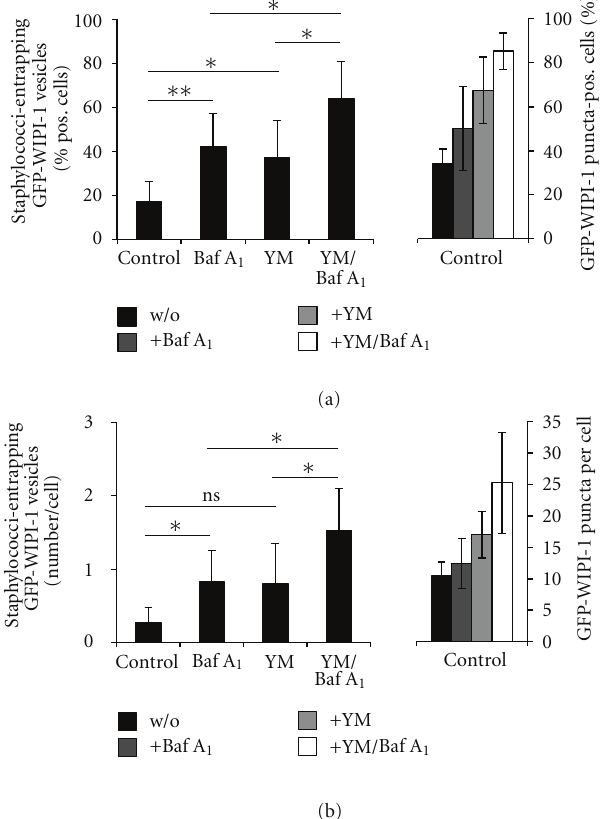
Figure 8: Bafilomycin A 1 and YM201636 treatments increased the number of GFP-WIPI-1 positive autophagosome-like vesicles entrapping Staphylococci. GFP-WIPI-1 U2OS cells were infected with S. aureus USA300 in DMEM/FCS in the absence (control) or presence of 200nM bafilomycin A 1 (Baf A 1 ), 800 nM YM201636 (YM), or with both (Baf A 1 /YM) for 2h. Images were automatically acquired (not shown). The number of GFP-WIPI-1 puncta-positive cells ((a), right panel) and the number of GFP-WIPI-1 puncta per cell ((b), right panel) was determined. From 100 infected cells for each of the treatment condition, the number of cells displaying GFP-WIPI-1 positive autophagosomal-like vesicles entrapping S. aureus USA300 ((a), left panel) and the number of GFP-WIPI-1 autophagosomal-like vesicles entrapping S. aureus USA300 per cell ((b), left panel) was determined ( n = 3). ∗ P < 0 . 05, ∗∗ P < 0 . 01, ns: not significant.